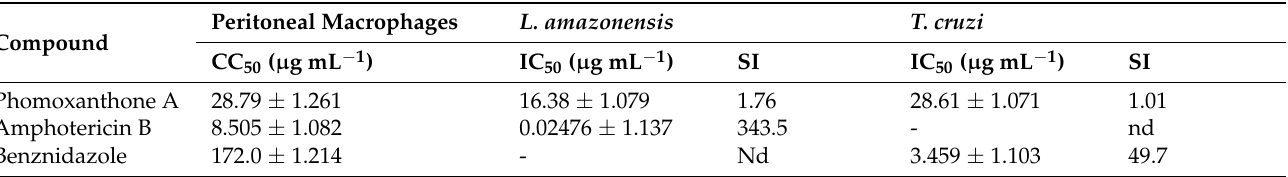
Table 2. Evaluation of the antileishmanial and trypanocidal activity of substances isolated from Paecilomyces sp.